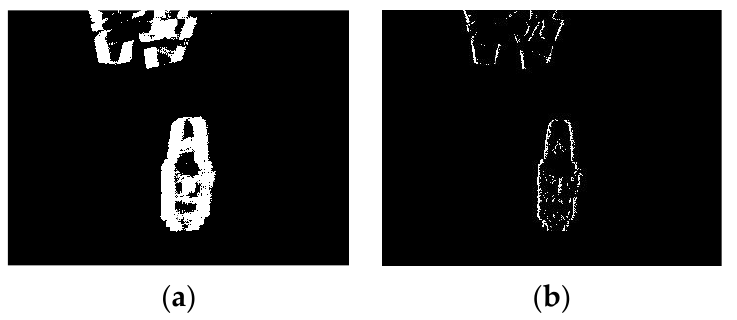
Figure 6. ( a ) A virtual frame composed of cumulative events; ( b ) a reference frame with clear and sharp edges obtained by the past events remove mechanism.